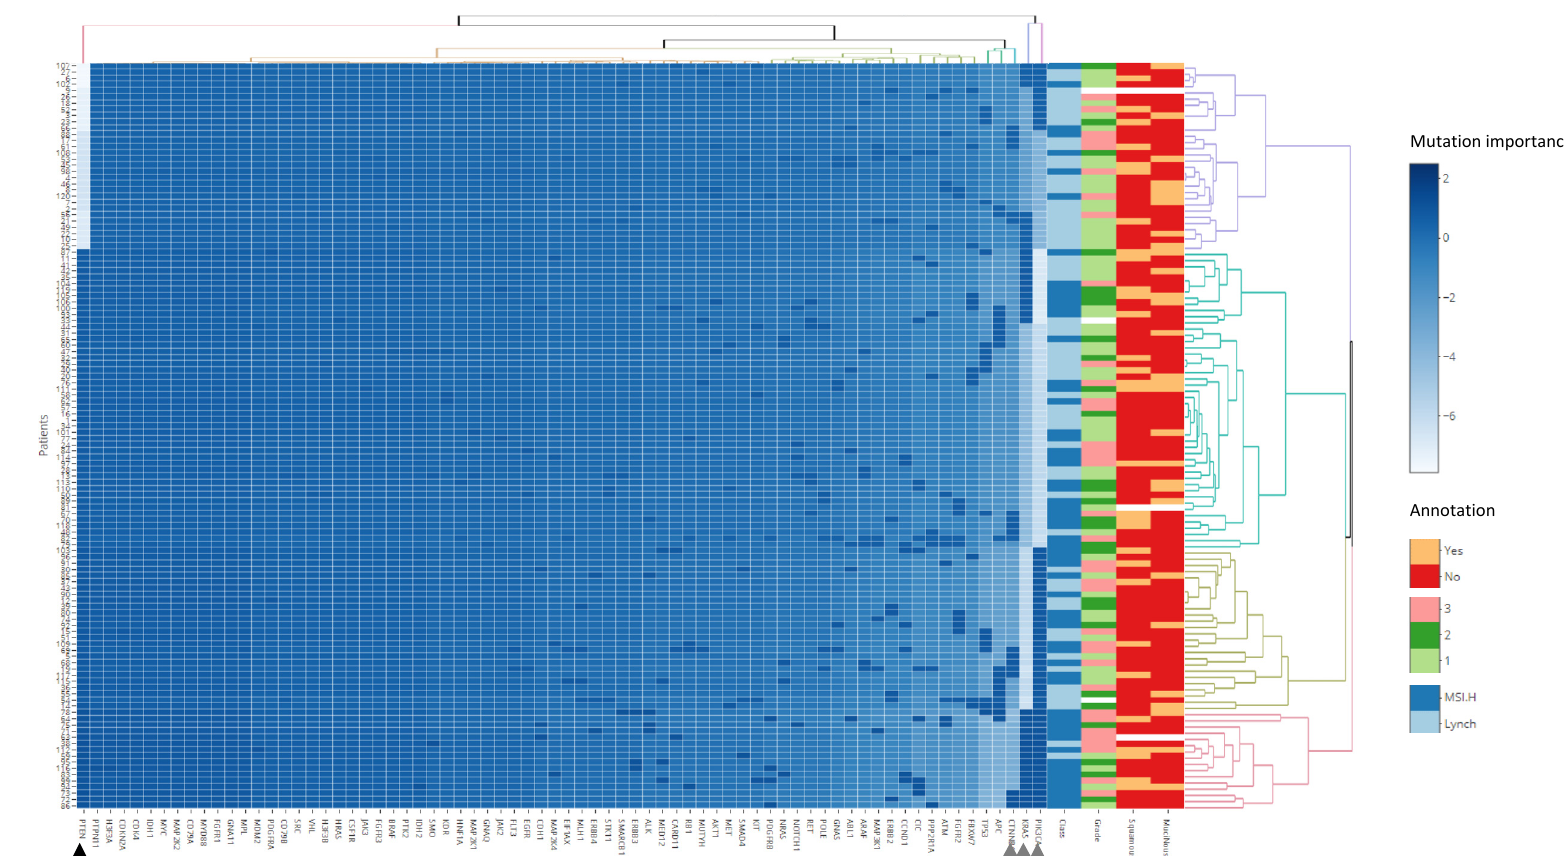
Figure 3. Mutational profiles. A panel of 75 genes classified by “ever mutation” for 61 LS-EC and 59 sporadic MMRd patients. Clinical annotations for class, grade, squamous and mucinous differentiation are provided as the rightmost columns. Intensities represent standardised and scaled signatures per patient observations (rows). Four principal dendrogrammatic clusters of genetic mutational signatures were observed indicative of genomic assault substructure within the pathologies. Gene clustering present mutations in PTEN (black triangle); PIK3CA , KRAS and CTNNB1 (grey triangle) as the most important events in the two pathologies. Of interest, the purple dendrogram cluster shows wild type PTEN associates predominantly with Lynch syndrome (22 out of 30 patients; light blue “class” annotation). Co-occurring mutations in PTEN ; PIK3CA , and KRAS predict predominantly a sporadic MMRd phenotype (15 out of 17 patients; dark blue “Class” annotation; peach dendrogram). No associations were observed between the mutational signatures and disease grade, squamous, or mucinous differentiation status.